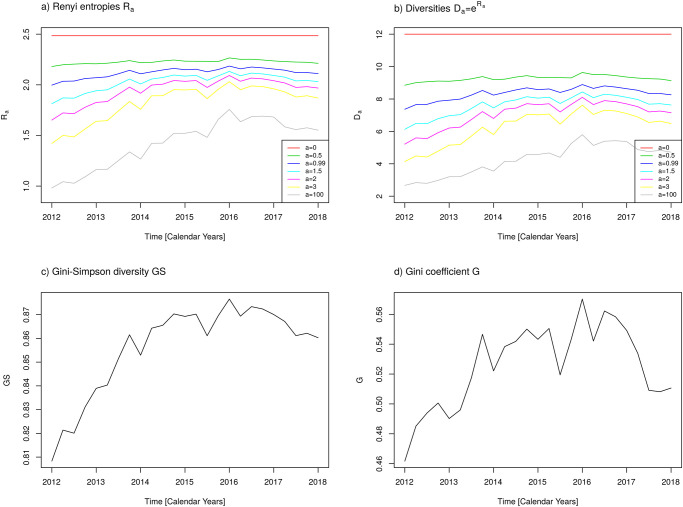
Measures of diversity with respect to antibiotic classes.a) Renyi entropies Ra for a = 0, 0.5, 0.99, 1.5, 2, 3, 100, b) Diversities Da for a = 0, 0.5, 0.99, 1.5, 2, 3, 100, c) Gini-Simpson index GS, d) Gini coefficient G.